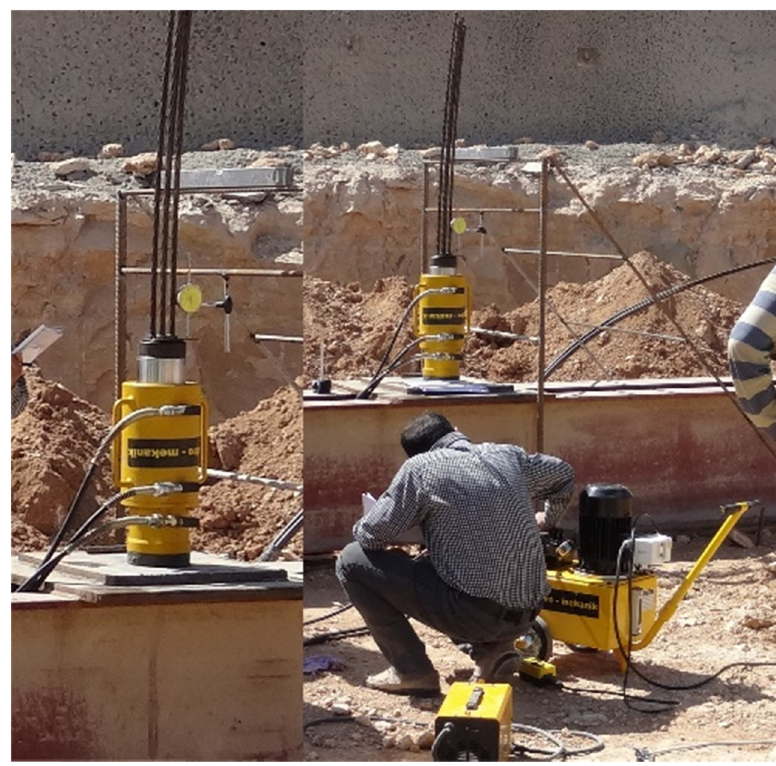
Figure 6: Testing frame and pullout jack.